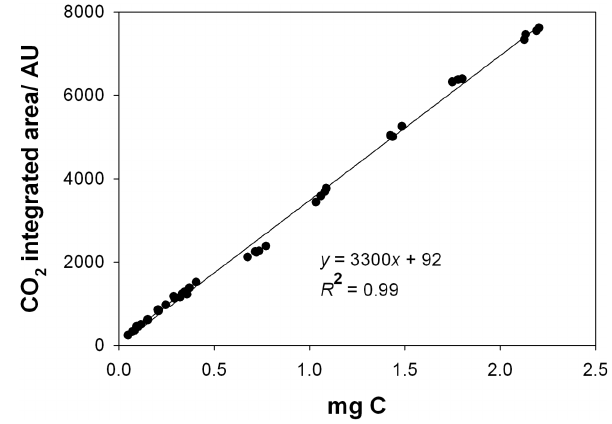
Figure 3 Fig. 3. CO 2 calibration curve of the FTIR-EGA with NaHCO 3